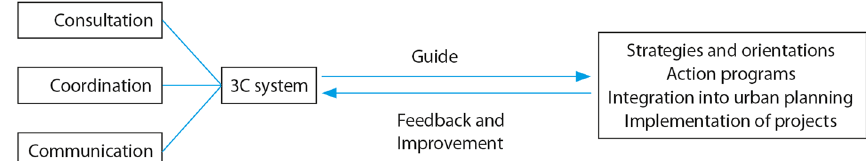
Fig. 14 A self-improving management system (Source: Liang Peng and Alain